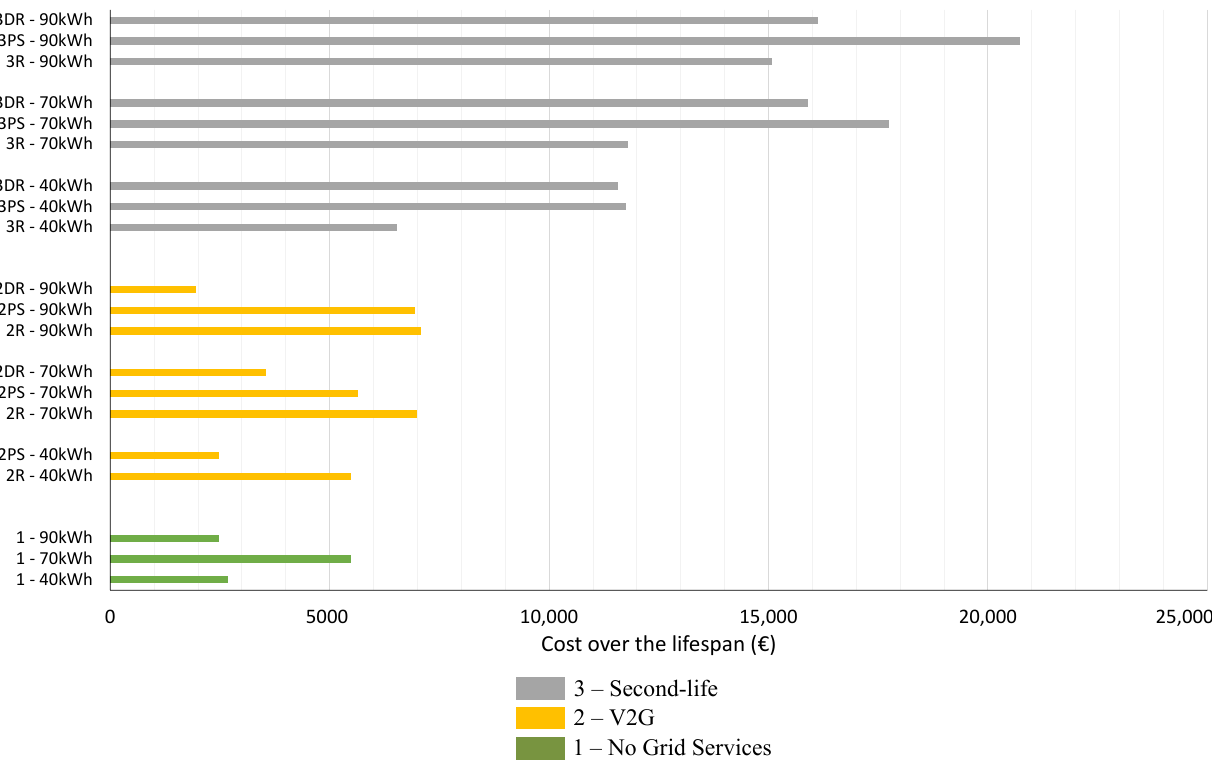
Figure 5. Cost over the battery lifetime for the different use cases: 1—No grid Services, 2—V2G, and 2—Second-life (R: residential, PS: peak shaving, DR: demand response) .